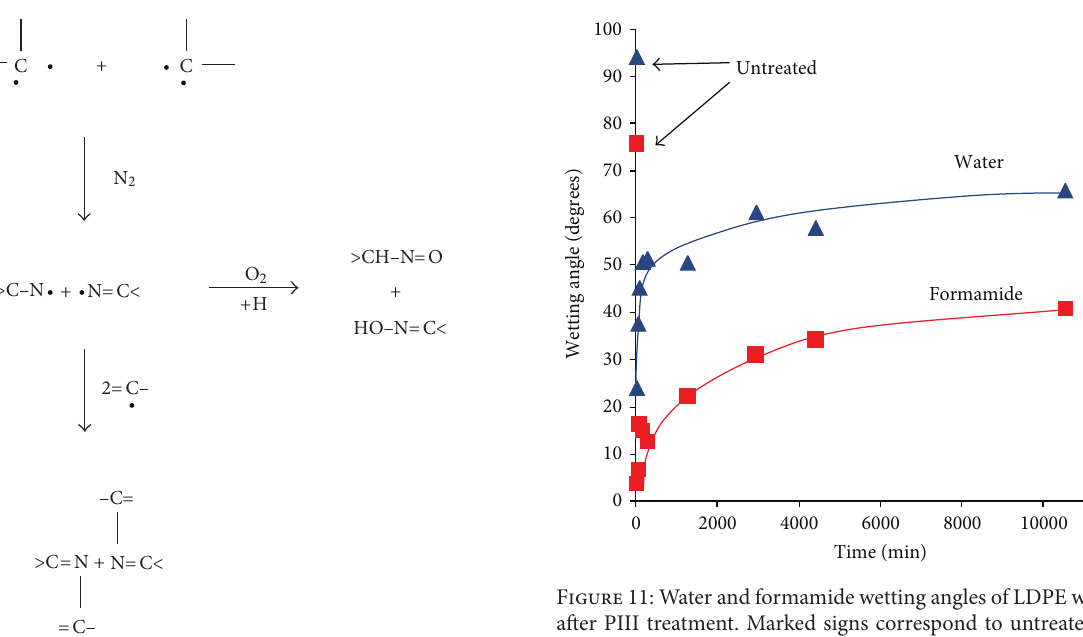
m (le image) and 10 𝜇𝜇